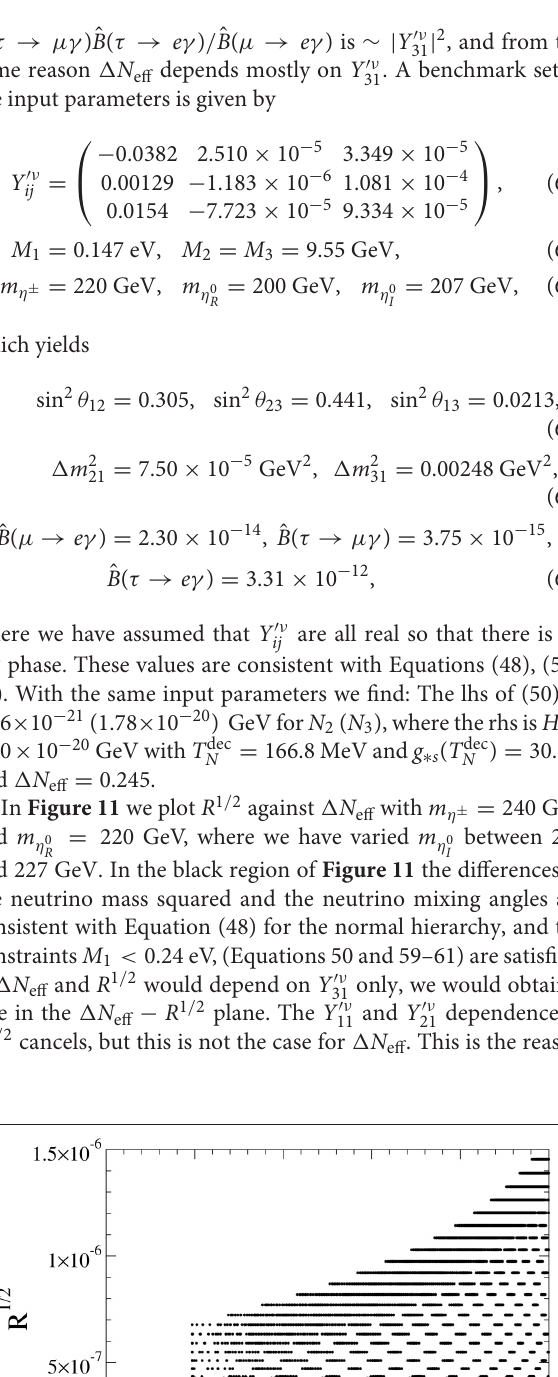
240 GeV and m η 0 220 GeV, ± = R = B ( τ µγ ) = ˆ →